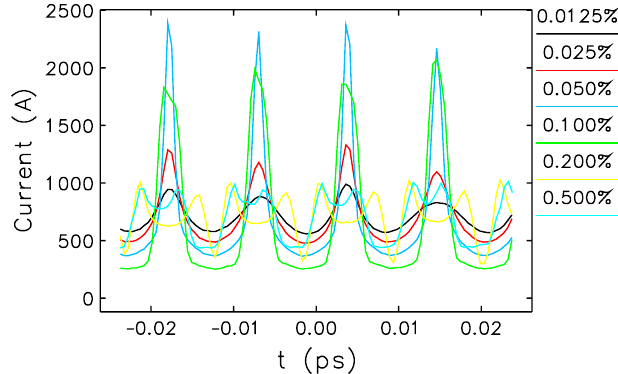
FIG. 9. (Color) Wavelength compression factor of FERMI as a function of the initial wavelength of the density modulation and its depth. Values in excess of 10 are not shown.